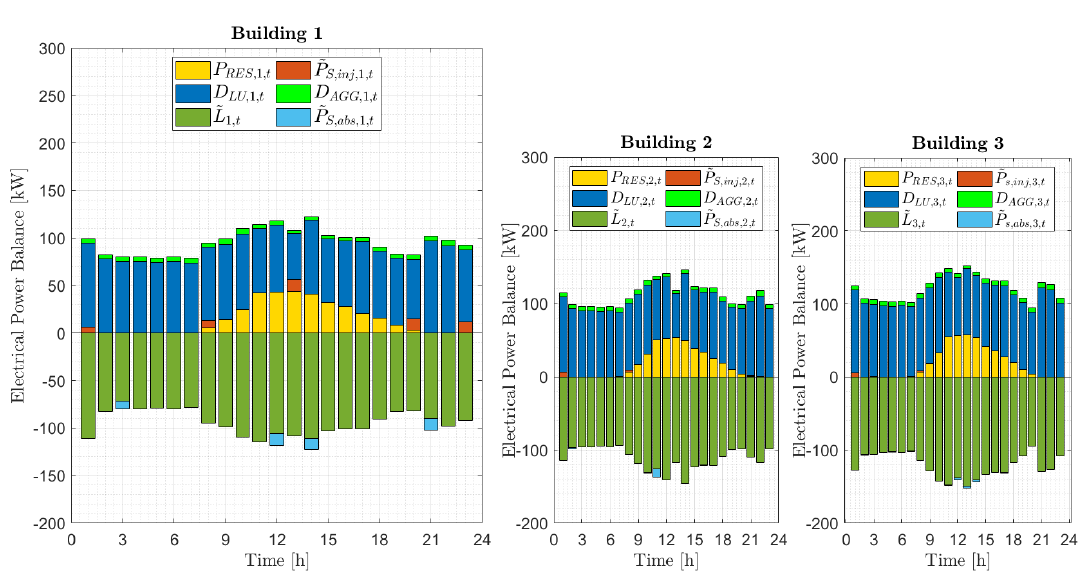
Figure 12. Power exchange between the nodes and the LUs (microgrids) compared with their reference values. In Figures 13 and 14 both the electrical (51) and thermal balances (56)are reported, highlighting the variety of the energy production pool. Specifically, the presence of two microturbines for each of the three microgrids, one with electrical nominal power of 35 and 65 kW (C30 and C65, respectively). The fraction of the load satisfied through the energy bought from the grid is definitely lower than in